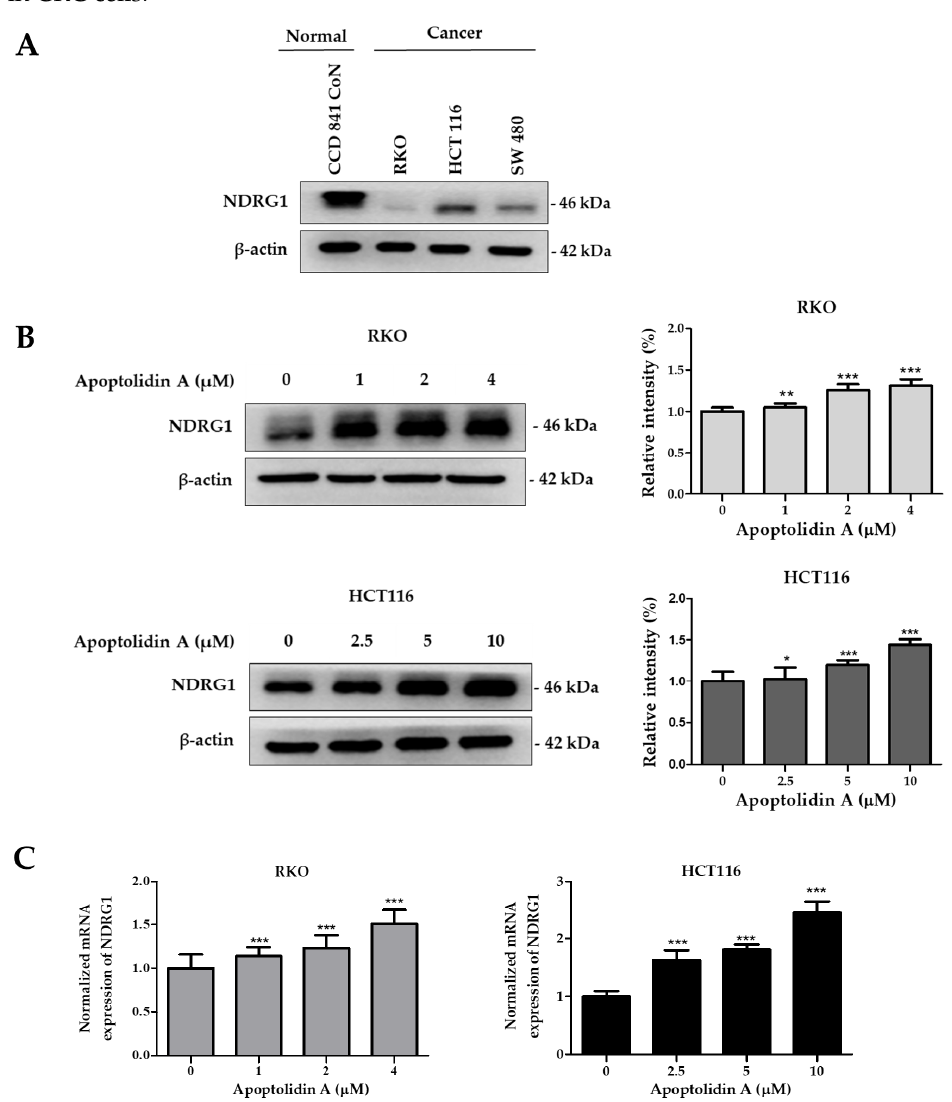
Figure 4. Effects of apoptolidin A on N-Myc downstream-regulated gene 1 (NDRG1) expression in CRC cells. ( A ) The expression of NDRG1 protein in normal epithelial colon cells and CRC cells was determined by Western blot analysis. β -Actin was used as an internal control. ( B ) Effects of apoptolidin A on NDRG1 protein expression after 24 h treatment in CRC cells. β -Actin was used as an internal control. ( C ) Real-time polymerase chain reaction (PCR) analysis of NDRG1 mRNA levels following 24 h treatment with apoptolidin A in CRC cells. Data are presented as the mean values ± SD from three independent experiments. * p < 0.05, ** p < 0.01, and *** p < 0.001 indicate statistically significant difference compared with the vehicle-treated